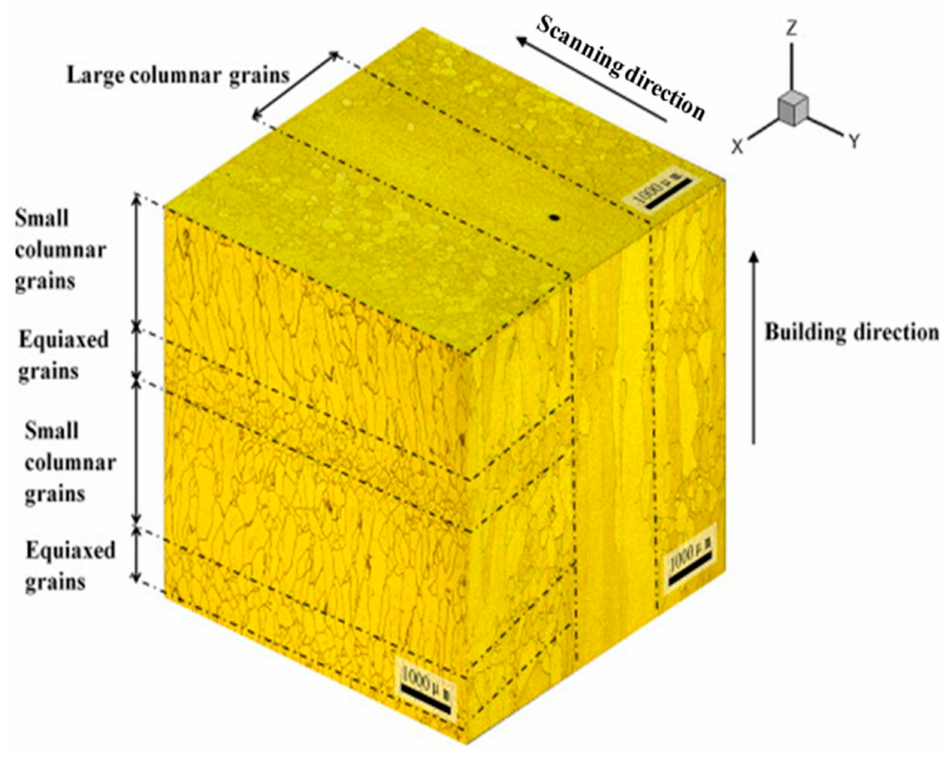
Figure 1. Typical β grain morphology of laser melting deposited Ti-5Al-5Mo-5V-1Cr-1Fe, at the center of the plate-like sample (reproduced with permission from [28] Copyright Elsevier,